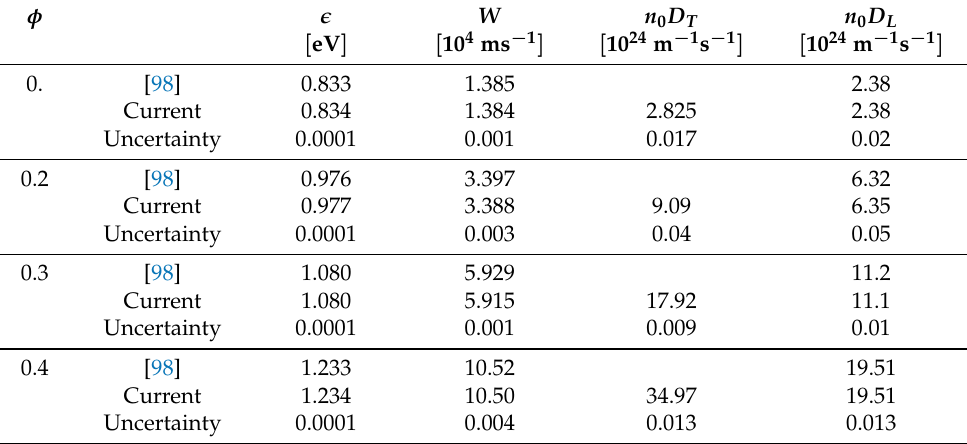
Table A2. Swarm benchmark results for our modified Percus–Yevik benchmark (Equation (A2)), from the current MC code, presented alongside an independent solution to the Boltzmann equation [98]. Provided, for comparison, are the mean energies ( ε ), drift velocities ( W ), and the transverse ( D T ) and longitudinal ( D L ) diffusion coefficients for each value of φ . Note that error estimates are given by the standard deviation of each transport coefficient with respect to time. For this benchmark 10 5 particles were simulated for varying times, where averages were conducted over the latter half of the simulation time. φ (cid:101) W 0.